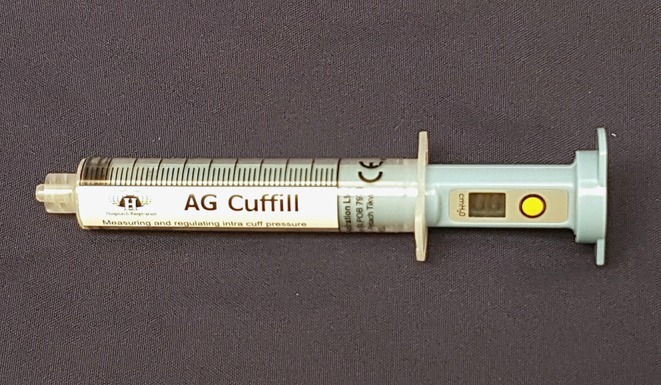
The AG Cuffill syringe has a pressure sensor in the device which can detect and display the ETT cuff pressure value on the screen of the plunger. The yellow button allows the reset of the pressure value.